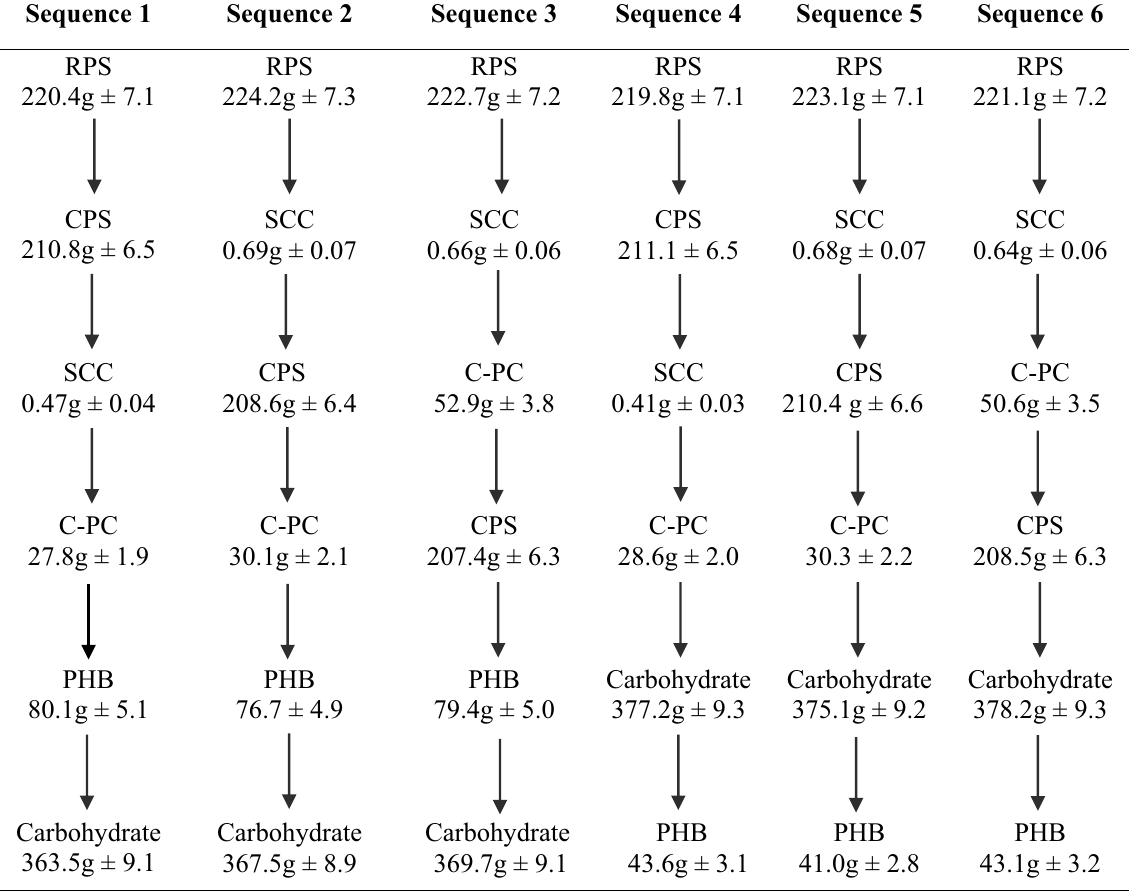
Table 9. Variation in the yield of different products from A. variabilis (equivalent to 1 kg dry biomass) grown in APL medium when placed in different sequential extraction positions. Values were calculated as the mean (± SE) of three independent observations, i.e., n = 3. RPS = released polysaccharides; CPS = capsular polysaccharides; Total EPS = RPS + CPS, where EPS refers to